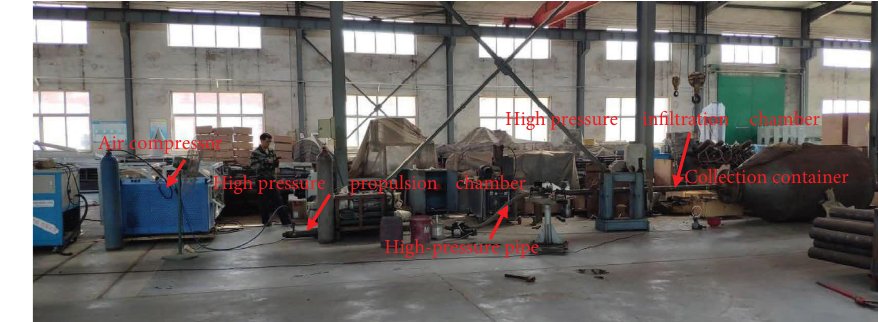
Figure 1: Schematic diagram of experimental apparatus.